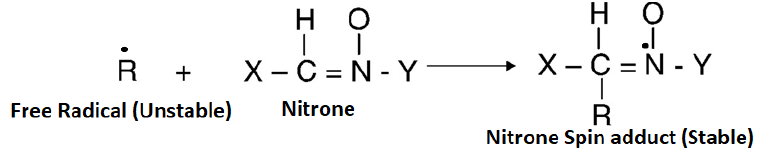
Figure 2. Spin trapping mechanism of an unstable free radical by a nitrone free radical to form a stable nitrone spin